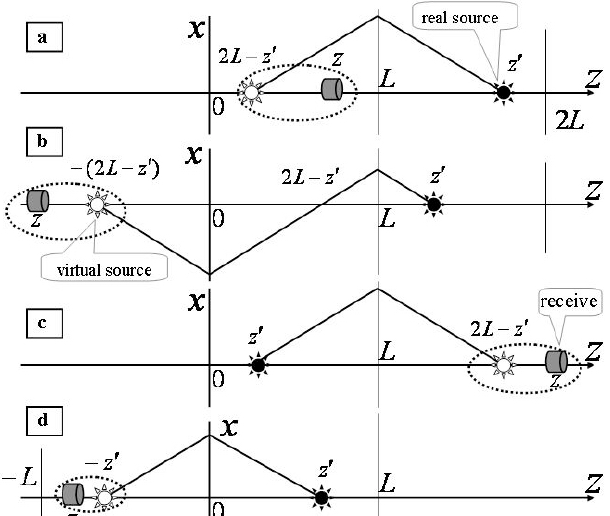
Figure 1: Singularity transfer by a homogeneous LHM slab from the right outside plane zz ʹ′ = , LzL 2 < ʹ′ < inside (a) and left outside (b) focal planes zLz ʹ′−→